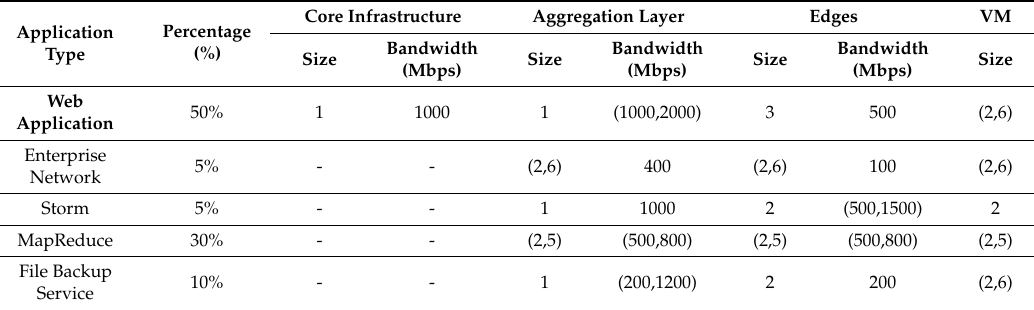
Table 2. Application in Cloud Datacenter Percentage.